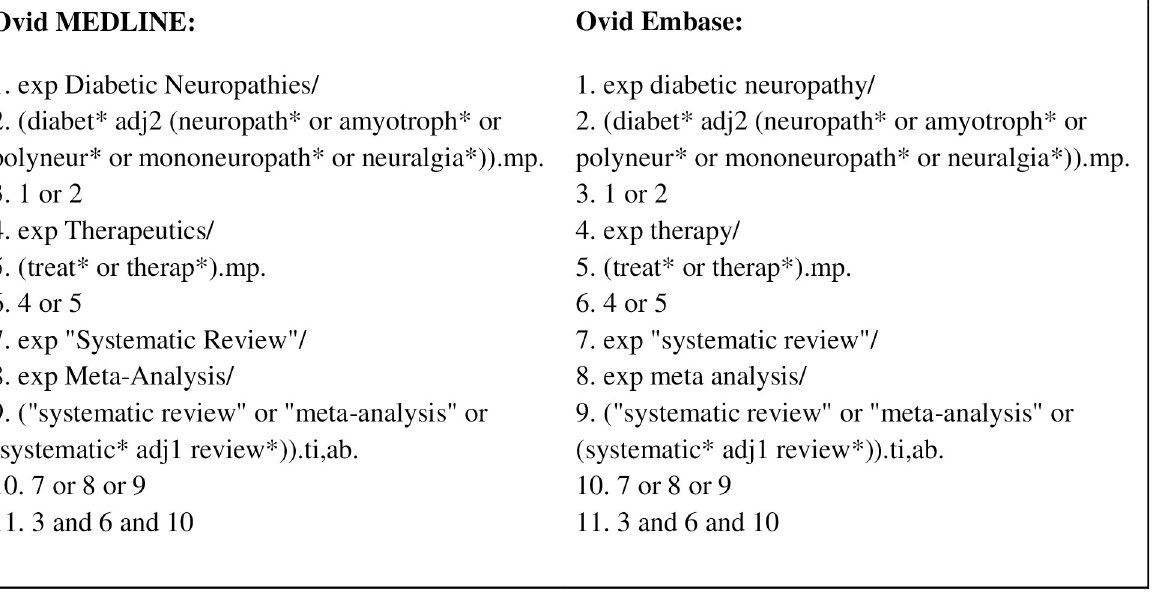
Fig 1. The search strategy to obtain systematic